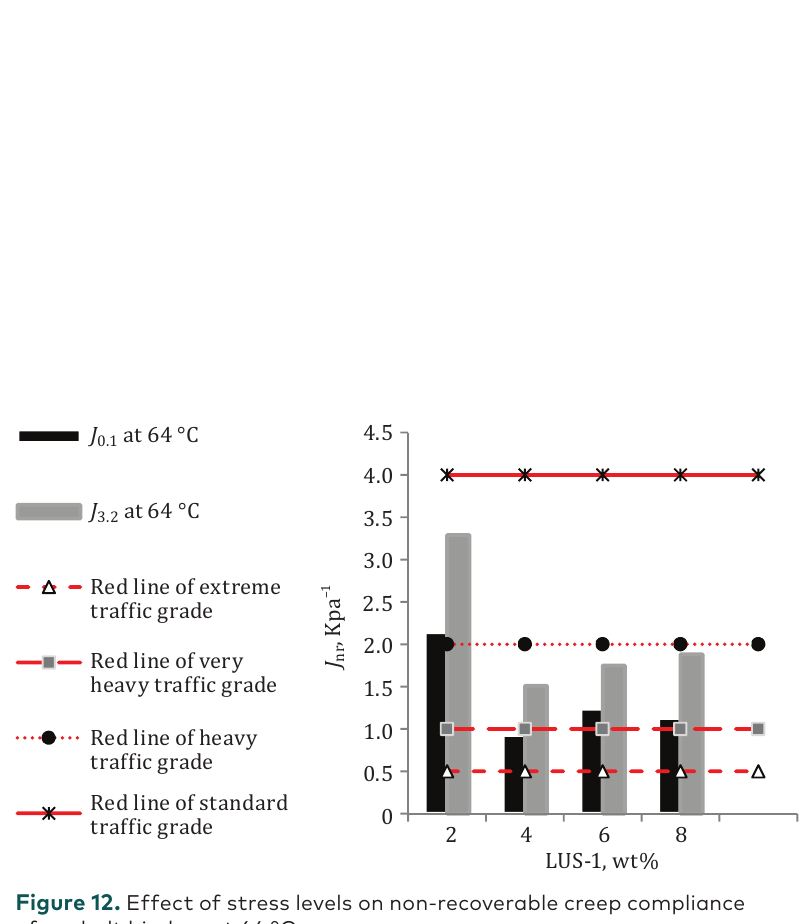
Figure 13. Effect of stress levels on non-recoverable creep compliance of asphalt binders at 70